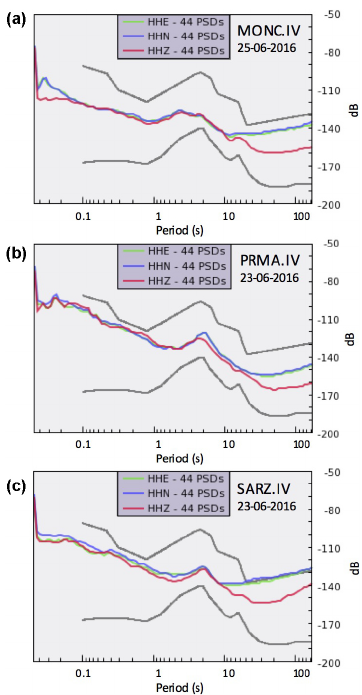
Figure 6. Median curves of the power spectral densities of the three components for three operating INGV permanent stations in the Po Plain basin (courtesy of CNT-INGV, Rome). (a) MONC is equipped with a Trillium 40s; (b) PRMA with a Trillium 120s and (c) SARZ with a Trillium 40s. The stations location is marked in Fig.